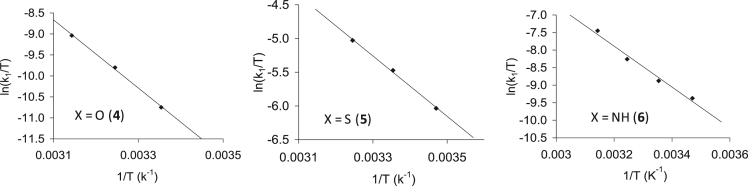
Eyring plots of ln(k1/T) vs 1/T for Rh(H3CCOCHCOCH3)CO(C6H5XPPh2), X = O (4), S (5) and NH (6) measured at temperatures ranging from 15 to 45 °C.